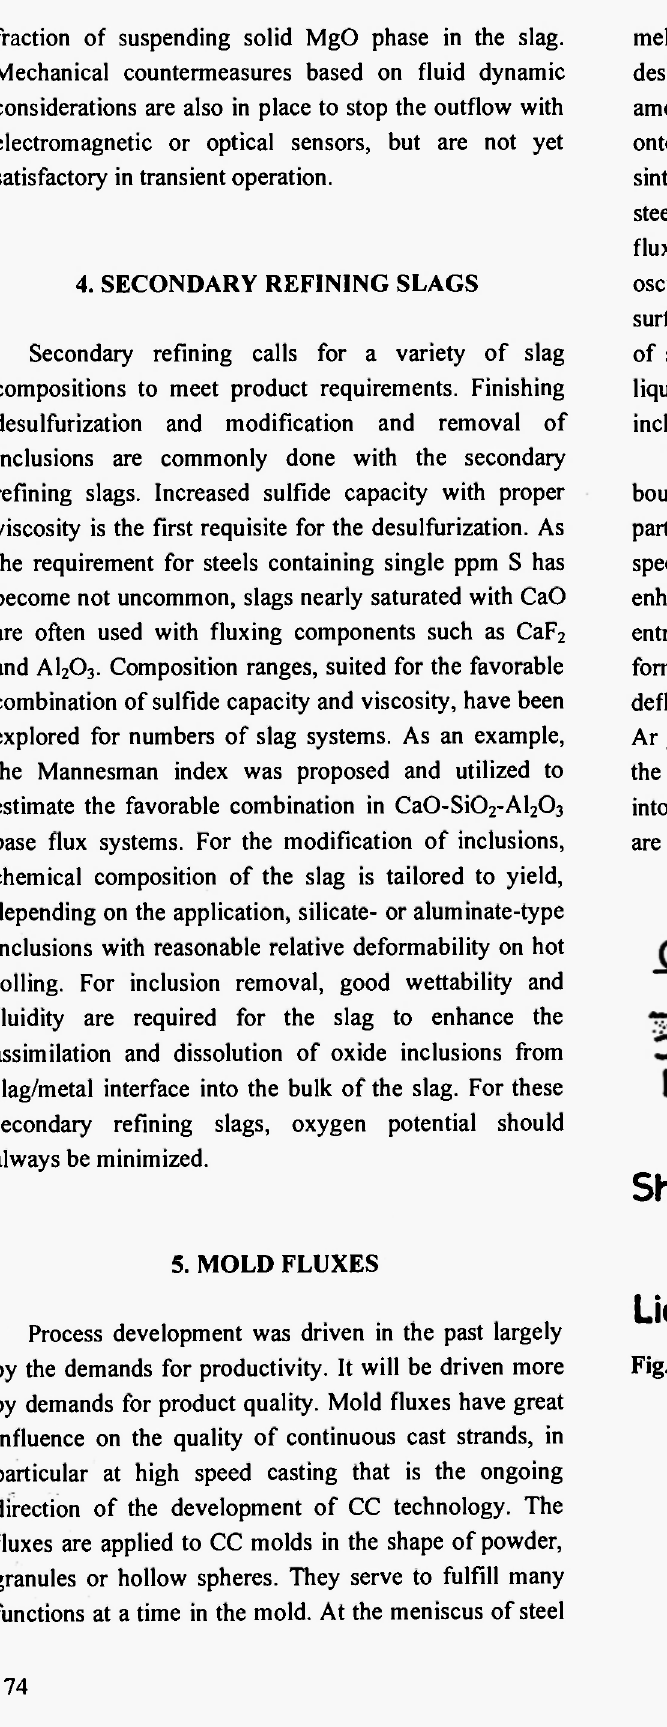
Four modes of mold flux entrainment at the flux/steel melt boundary (Mode A: by the turbulence caused by melt flow, Mode B: by vortexing, Mode C: by the turbulence caused by ascending motion and break up of Argon bubbles, Mode D: by the sedimentation